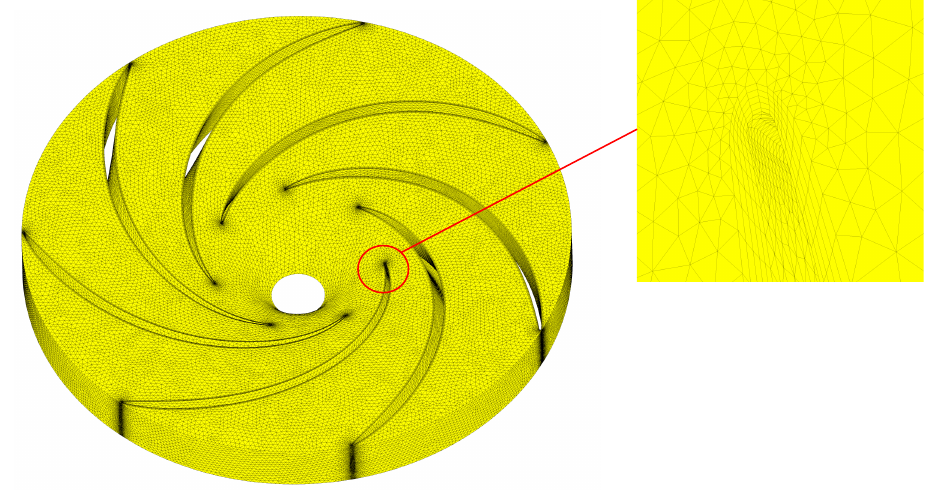
Figure 5. Mesh of the runner